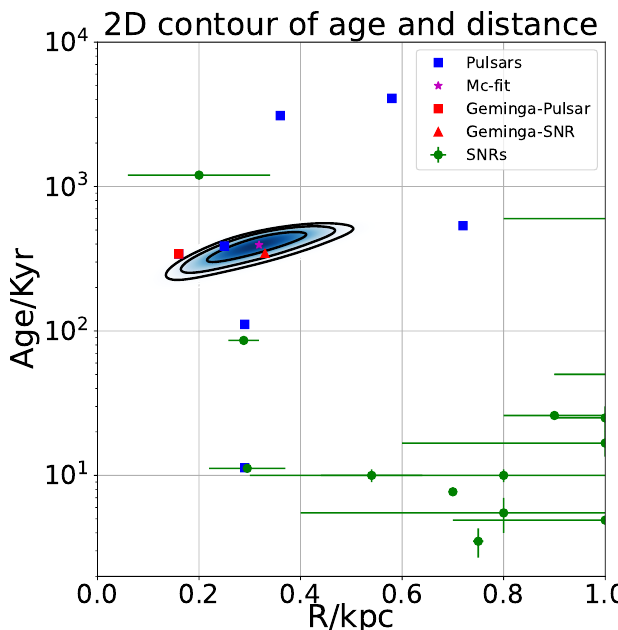
Figure 4. 2D contour of age and distance of local source. The violet star is best fit values of galactic longitude and latitude, and the solid lines are 1- σ , 2- σ , and 3- σ contours, respectively.